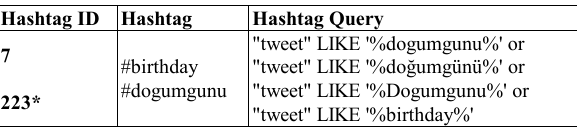
Table 1. Semantic Classification and Queries for